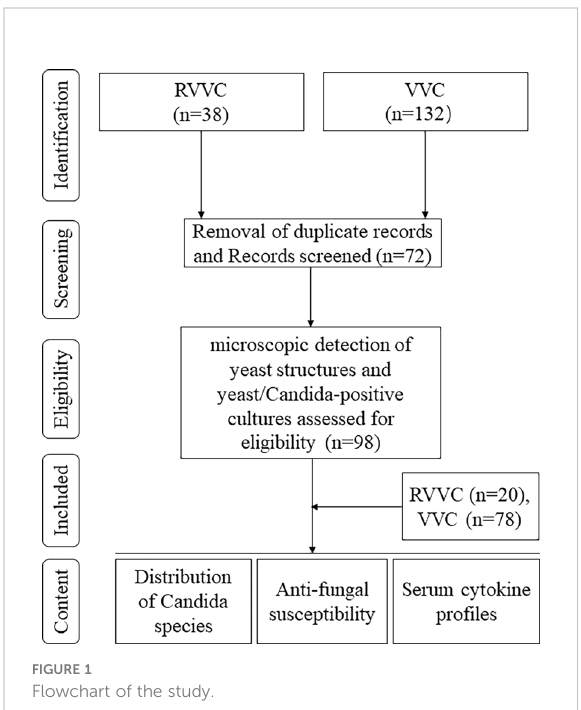
FIGURE 1 Flowchart of the